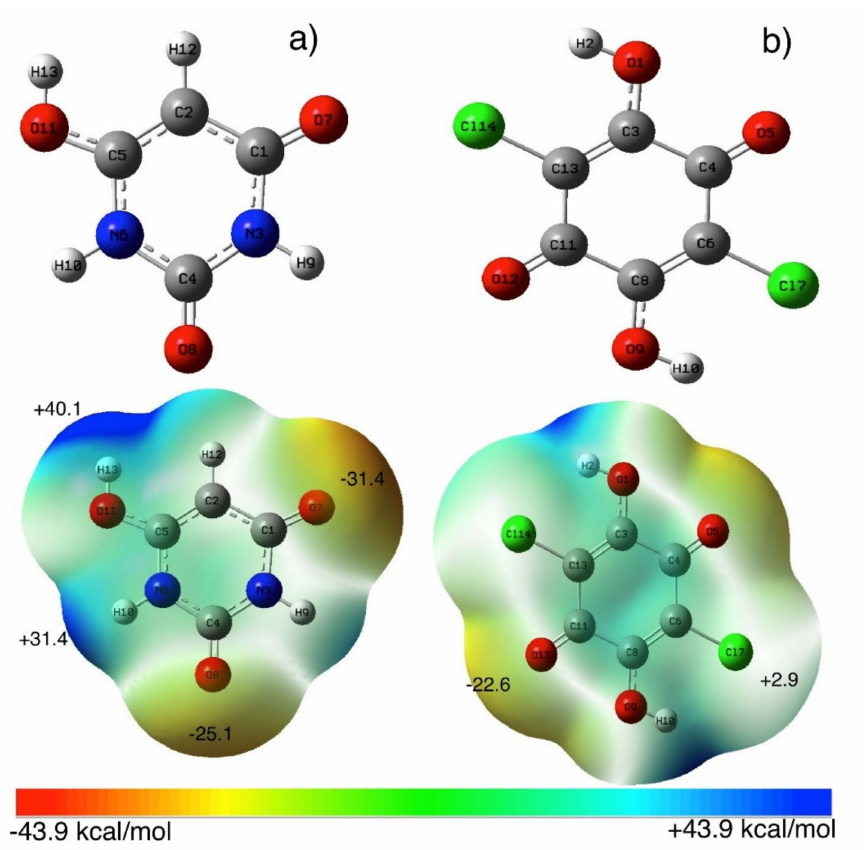
Figure 4. Optimized structure and MESP of ( a ) BU and ( b ) ChA in the gas phase calculated at wB97XD/def2-TZVP level of theory.